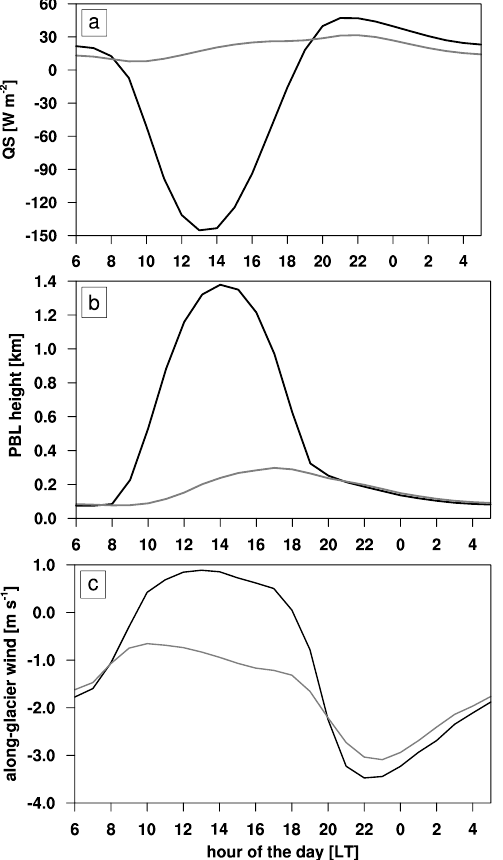
Figure 11. A comparison of the simulated diurnal cycle of (a) the turbulent flux of sensible heat, QS [Wm − 2 ]; (b) the planetary boundary layer (PBL) height [km]; and, (c) the along-glacier wind speed [from the lowest model level; ms − 1 ], which is positive for up-glacier flow. The data are averaged over exposed debris in DEB (black curve) and the corresponding grid cells in CLN (gray